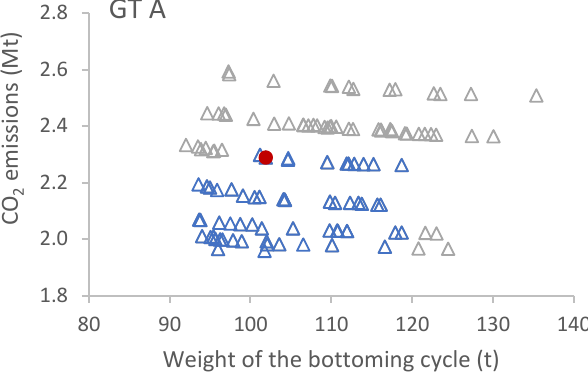
Figure 8. Visual representation of the screening mechanism of the Pareto designs. The grey empty diamonds are the designs screened out, the blue empty diamonds are the designs complying with the two criteria and the red full circle is the design selected.